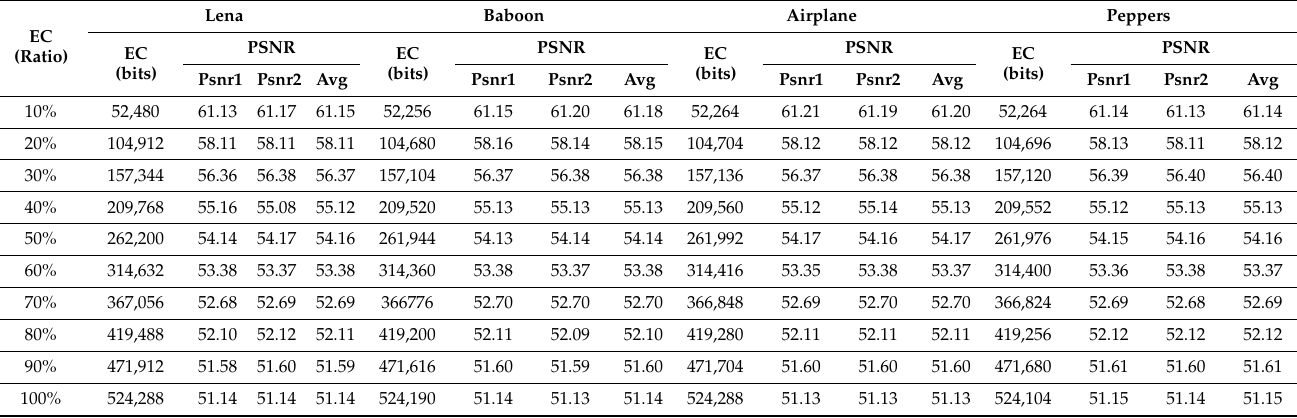
Table 3. Comparison of embedding capacity and PSNR value of different stego images for n = 1.